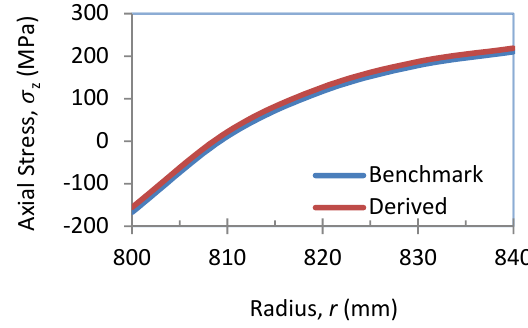
Figure 4. The variation of axial stress with cylinder radius.